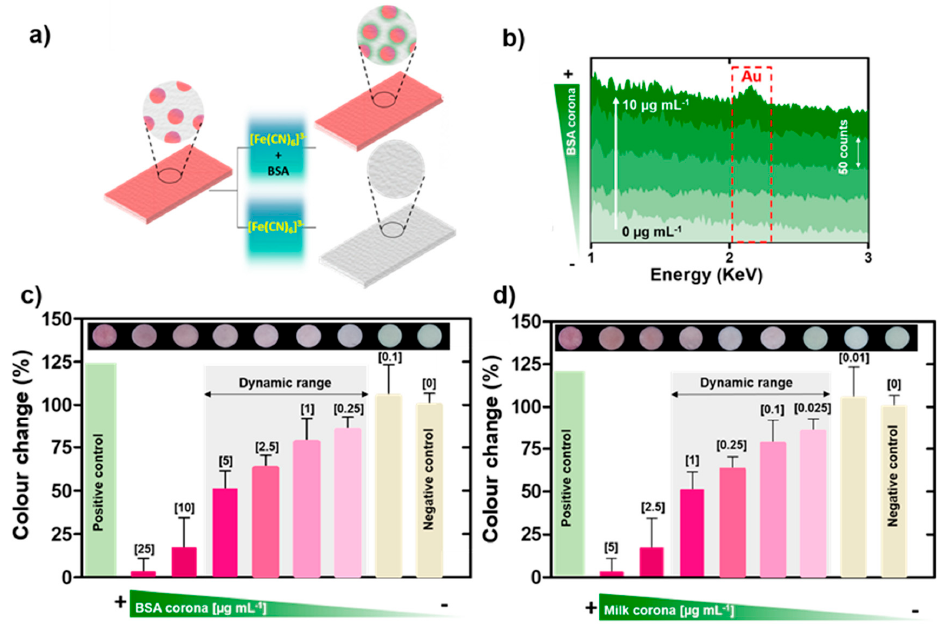
Figure 5. Nanoplasmonic platform for biomacromolecule screening. ( a ) Colour response of the nanoplasmonic paper to biocorona formation. ( b ) EDX analysis of papers exposed to ferricyanide with BSA concentrations ranging from 0 to 10 µg mL − 1 . ( c ) Graph and images showing the colour shift of nanoplasmonic papers exposed to ferricyanide with BSA concentrations ranging from 0.1 to 25 µg mL − 1 for 20 min. ( d ) Graph and images showing the colour shift of nanoplasmonic papers exposed to ferricyanide with milk concentrations ranging from 0.01 to 25 µg mL − 1 for 20 min. Colour shift is defined as the degree of change (expressed as percentage) with respect to the positive control (blank nanoplasmonic paper, 0%) and negative control (pristine paper, 100%) (error bars represent the standard deviation, n = 3).